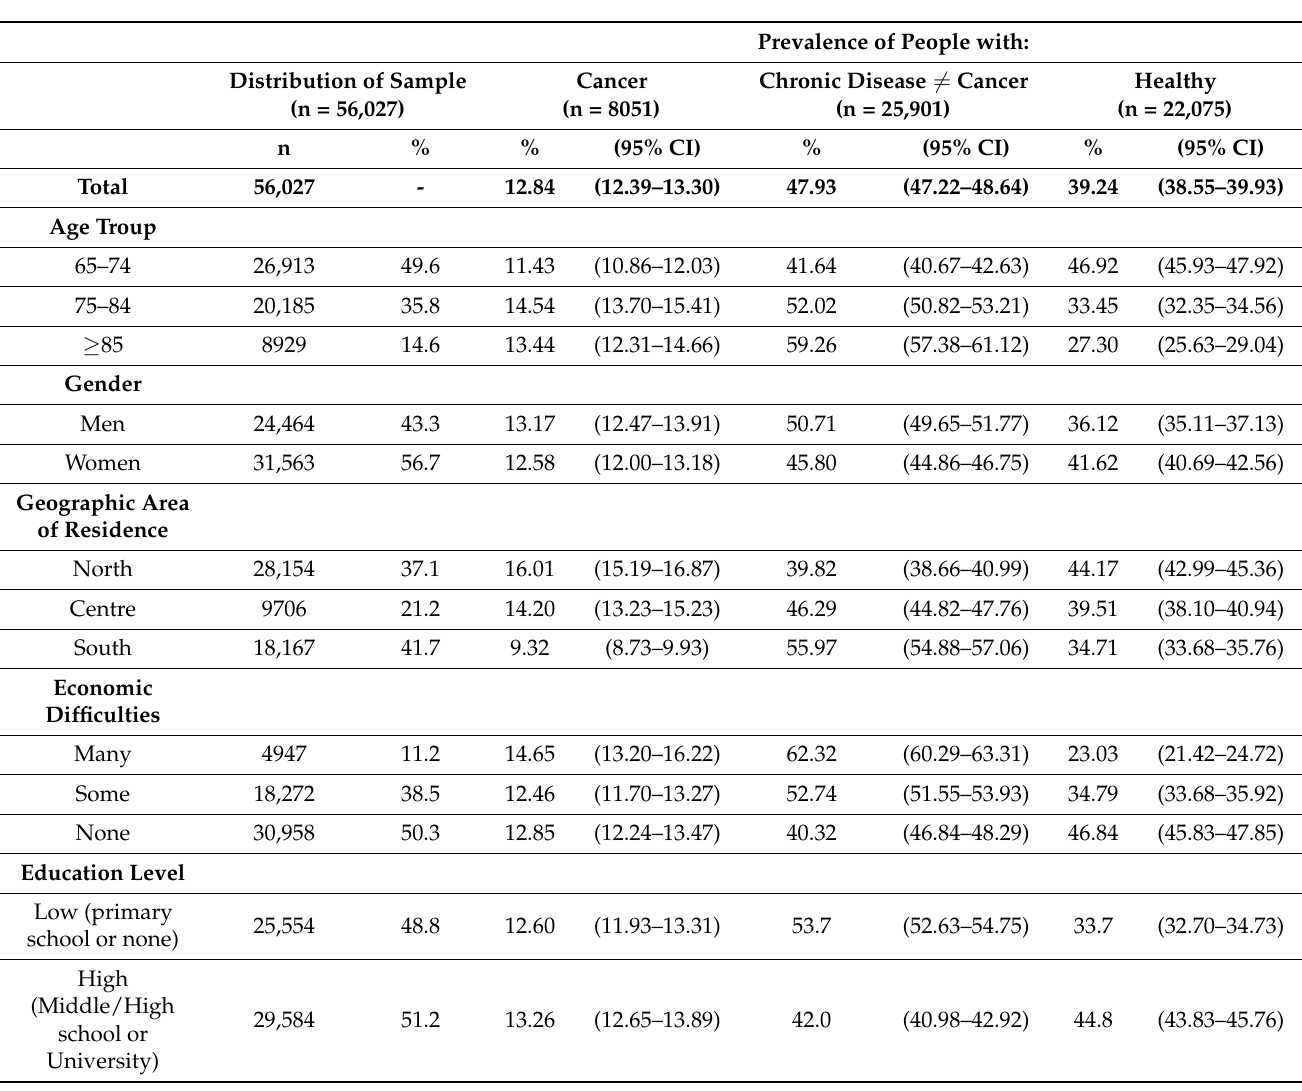
Table 1. Distribution of sample (n = 56,027) and prevalence of three groups of people aged ≥ 65 years (with cancer, with chronic disease other than cancer, and healthy) by socio-demographical character- istics. Passi d’Argento